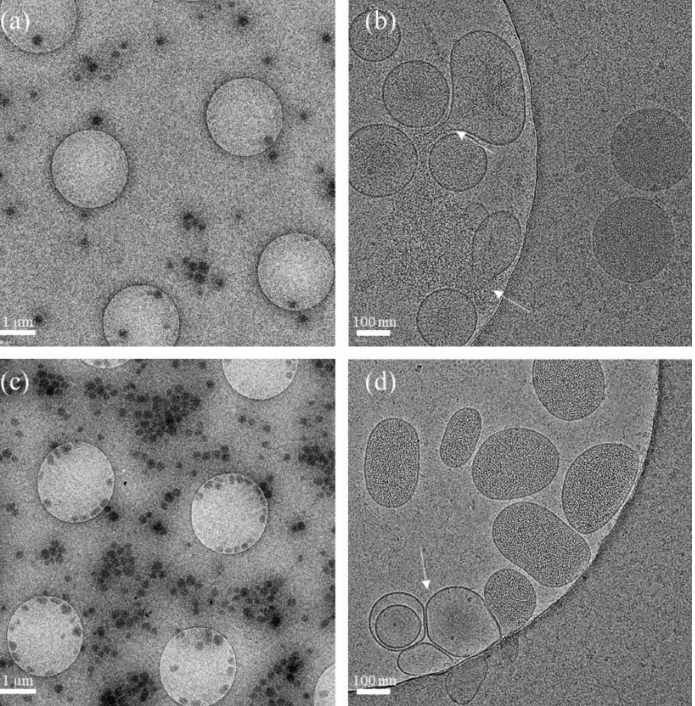
Figure 4. Cryo-TEM images of the hbEVs stored at 4 ◦ C for 6 weeks ( a , b ) (micrographs taken from the same grid, different magnifications), and for 7 months ( c , d ) (micrographs taken from the same grid, different magnifications). Arrows point to some ruptured ( b ) and lighter-shaded vesicles (indicating leakage of EV cargo) ( d